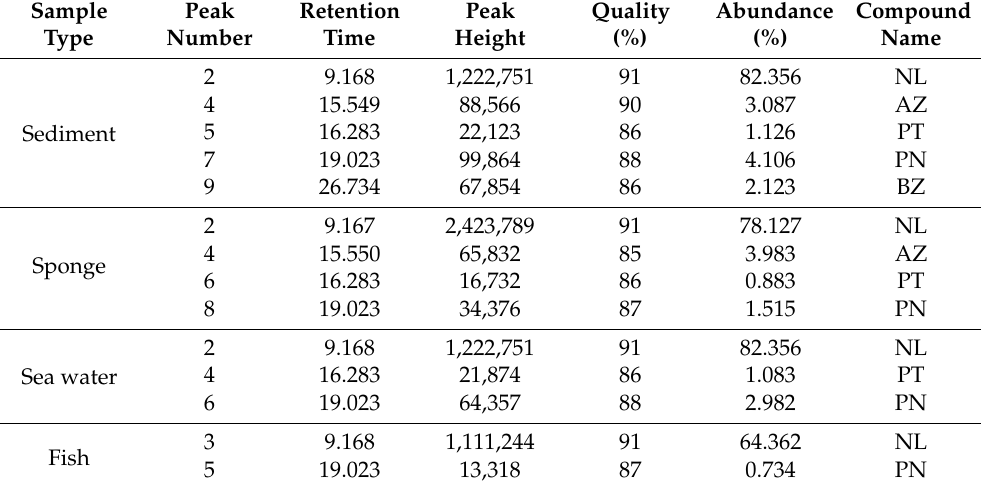
Table 6. Types and abundance of PAH in samples obtained from ST 3 based on the GC/MS chro-